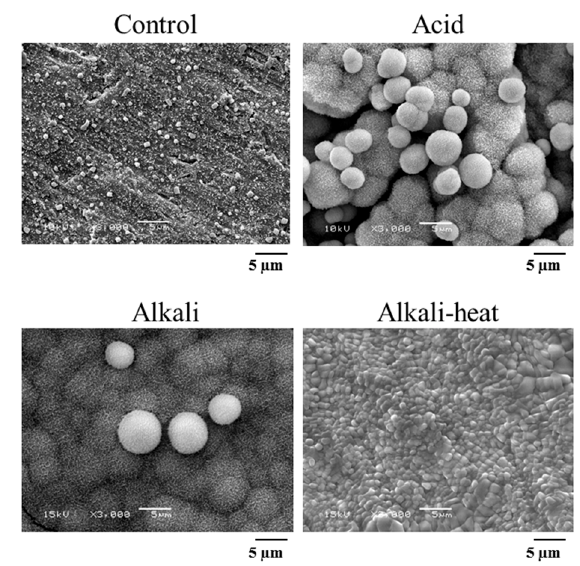
Figure 8. SEM pictures of the surface appearances of MDF-Ti disks after 1 day of HBSS immersion.